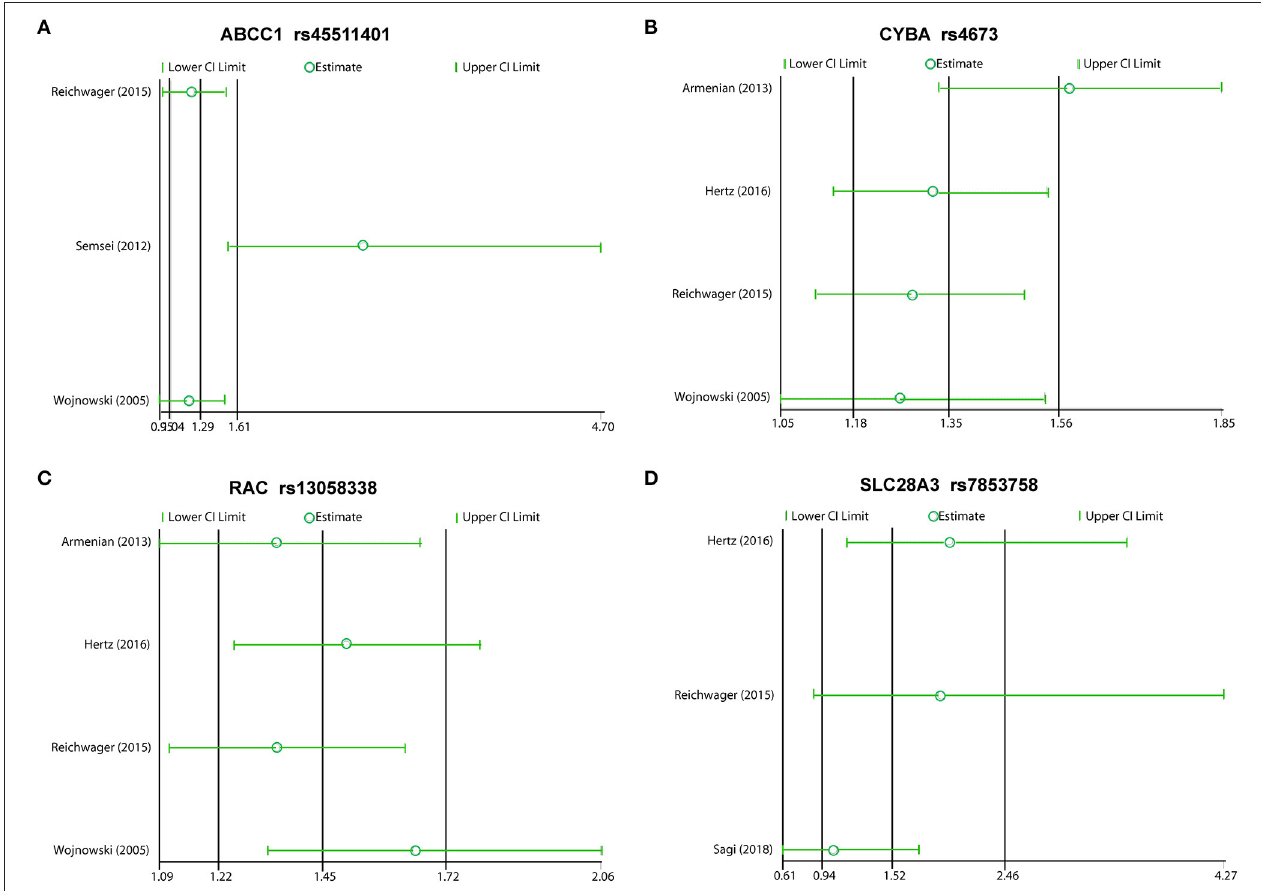
FIGURE 5 | Sensitivity analyses plot of ABCC1 (A) , CYBA (B) , RAC (C) , and SLC28A3 (D)